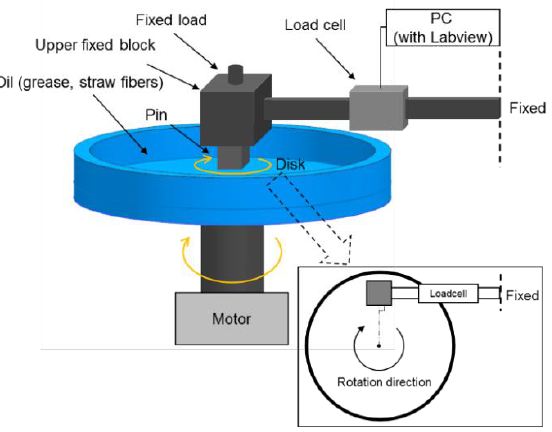
Figure 2. Pin-on-disk friction and wear